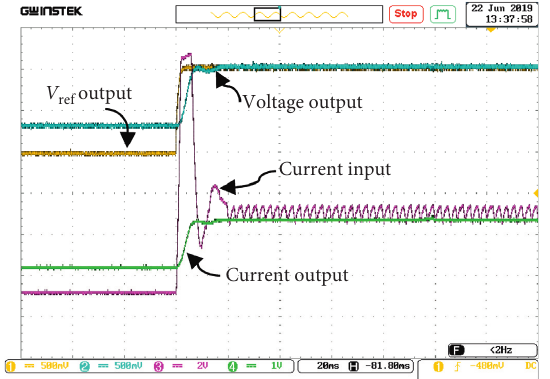
Figure 28: Result of maintaining voltage stability and current while changing load using a PI controller with TS search.